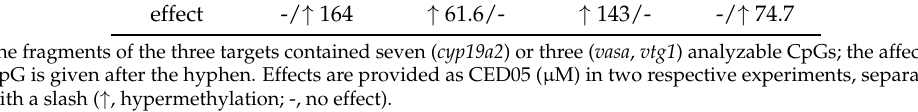
Table 1. Effects of cadmium on DNA methylation in 72 h post fertilization (hpf) zebrafish embryos. Target cyp19a2 -1